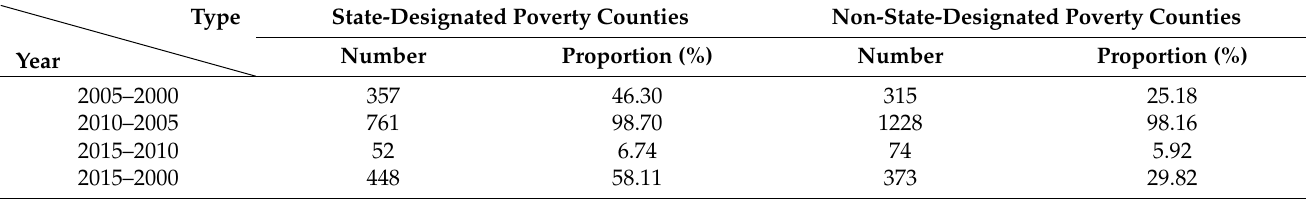
Table 6. Proportion of counties with increased CMPI value over time in state-designated poverty counties and non-state-designated poverty